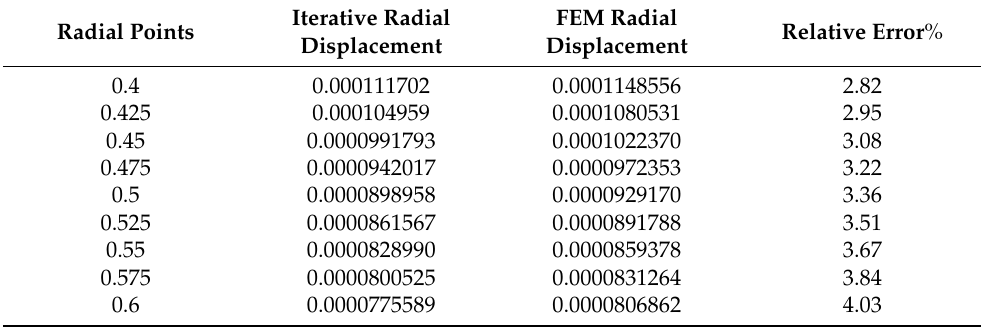
Table 1. Comparison of radial displacement in FGM cylinder using iterative technique and FEM under internal pressure, P a = 50 MPa and external pressure, P b = 20 MPa.